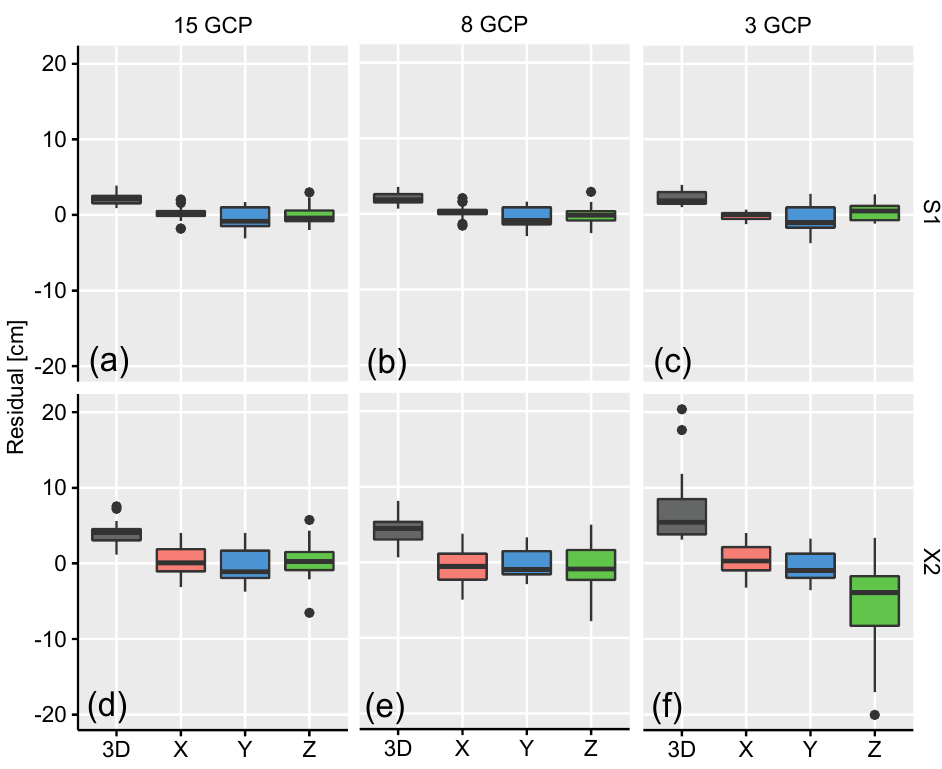
Figure 8. Comparison of CPs residuals for Palar study area using different cameras and different number of GCPs (3, 8 and 15 GCPs). ‘S’ surveys were performed with the Sony camera ( a – c ), whereas ‘X’ refers to X5S datasets ( d – f ). The 3D total error is reported in grey, while pink, blue and green represents residuals in the X , Y and Z direction,